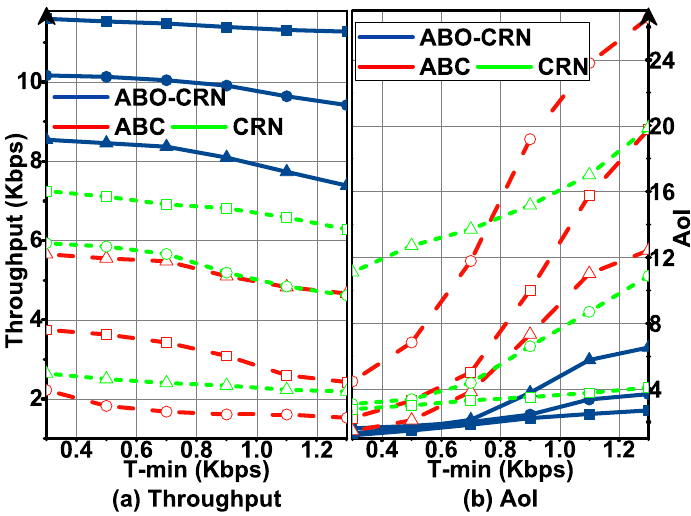
Figure 8. Throughput T and AoI versus T min under P a = 0.3 (circle), 0.6 (square), 0.9 (triangle) compared with that in the ABCs and CRNs, and A max = 5: ( a ) describes the throughput performance. ( b ) describes the AoI